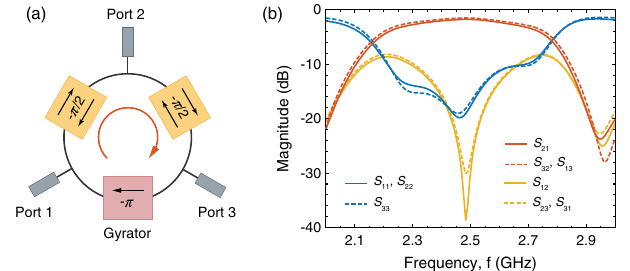
FIG. 9. (a) Schematic of a circulator operated at f 0 ¼ 2 . 5 GHz, comprised of three commutated networks as in Fig. 1, with ¼ 1 GHz, C ¼ 0 . 65 pF, and L ¼ 1 nH. Two of them N ¼ 16 , f s are configured to provide a reciprocal phase shift ϕ 21 ¼ ϕ 12 ¼ − π = 2 at f ¼ f Δ T ¼ T = 2 0 by choosing the switching delay s = 5 ( γ ¼ − 2 π = 5 ), ( γ ¼ − π ). The third network has Δ T ¼ T s leading to a gyrator response ϕ 21 ¼ − π and ϕ 12 ¼ − 2 π at f ¼ f 0 . (b) Corresponding scattering parameters computed using the numerical approach described in the